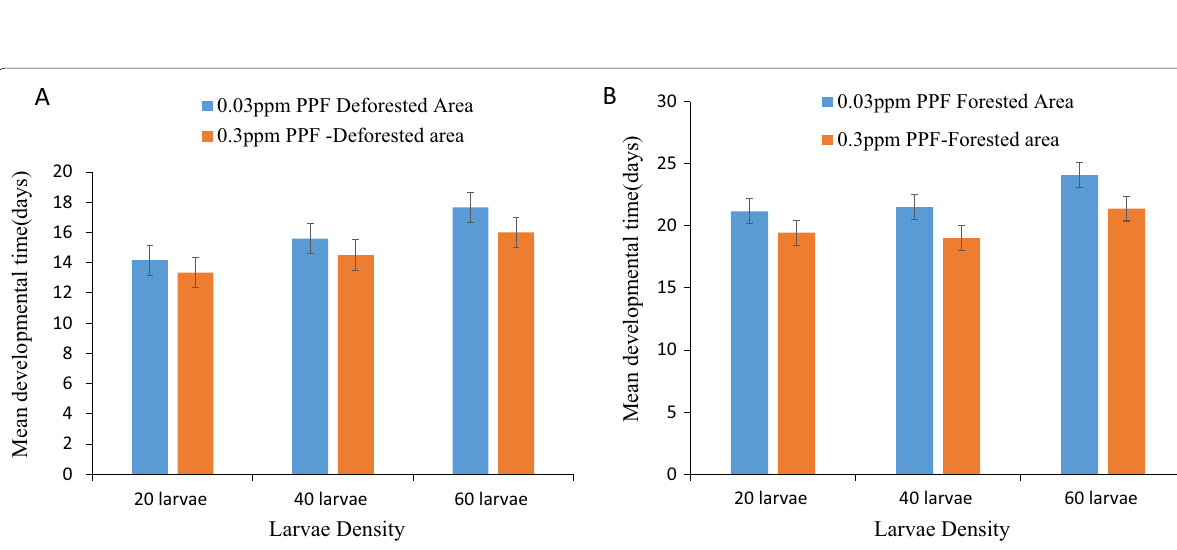
Fig. 5 The effect of increasing PPF concentration from 0.03 to 0.3 ppm ( A and B ) on An. gambiae s.s. developmental time at densities of 20, 40 and 60 larvae. Experiments were repeated 6 times and in 3